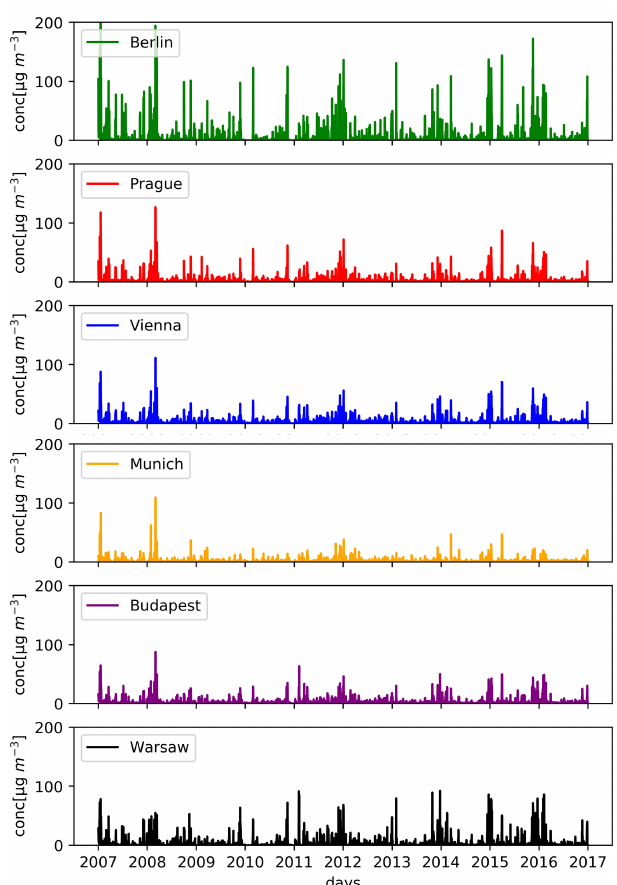
Figure 18. Daily averaged impact of wind-blown dust emissions on PM 10 concentrations in micrograms per cubic metre for 2007–